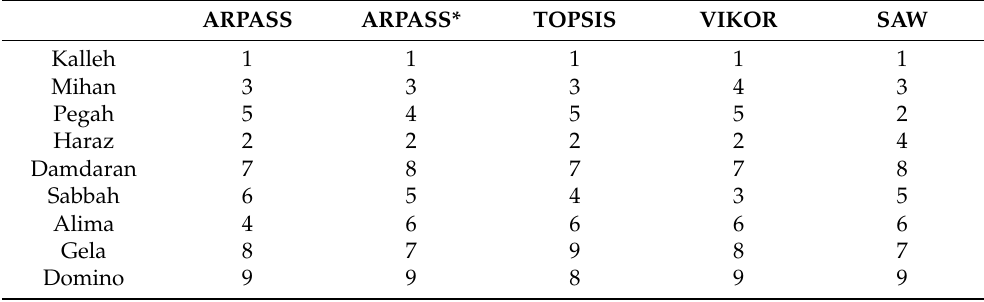
Table 20. The ranking results in ARPASS, TOPSIS, SAW, VIKOR, and ARPASS* methods.